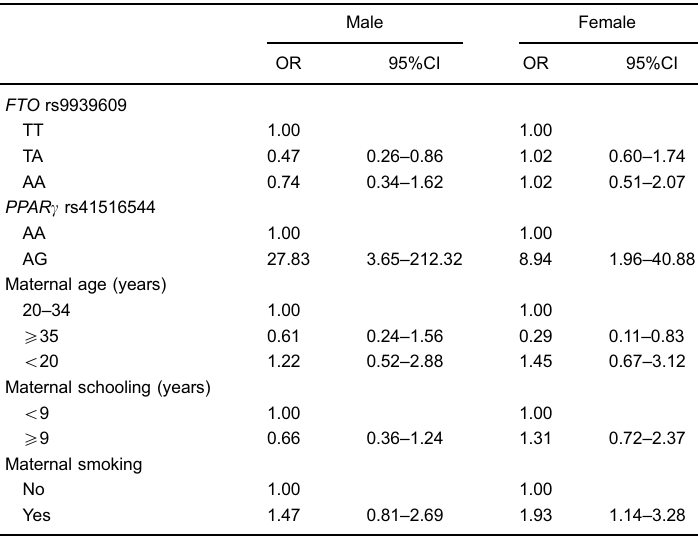
Table 4. Adjusted associations of FTO (fat mass and obesity-associated) and PPAR g (peroxisome proliferator-activated receptor-gamma) genotypes and maternal characteristics with intrauterine growth restriction